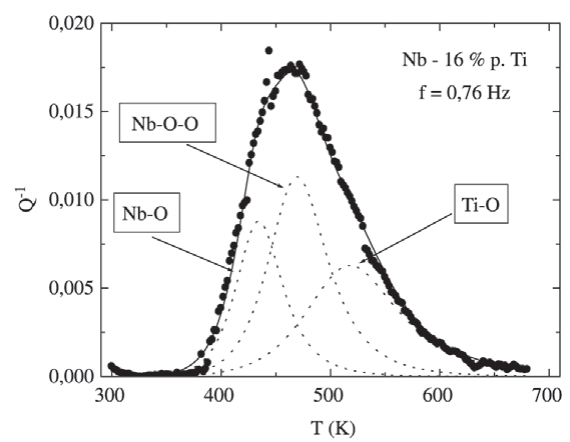
Figura 4. Decomposição em picos de Debye do espectro de atrito interno em função da temperatura para a liga Nb -16% p. Ti, medido com freqüência inicial de 0,76 Hz.